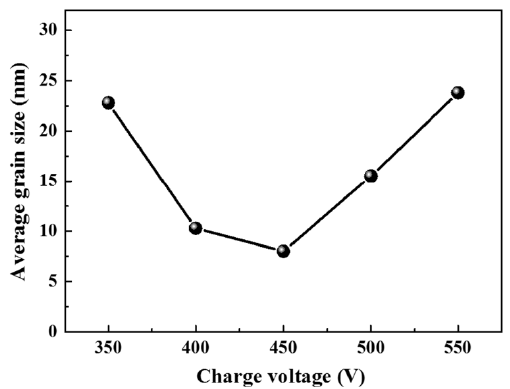
Figure 4. Average grain size of AlCrN coatings as a function of the charge voltage.